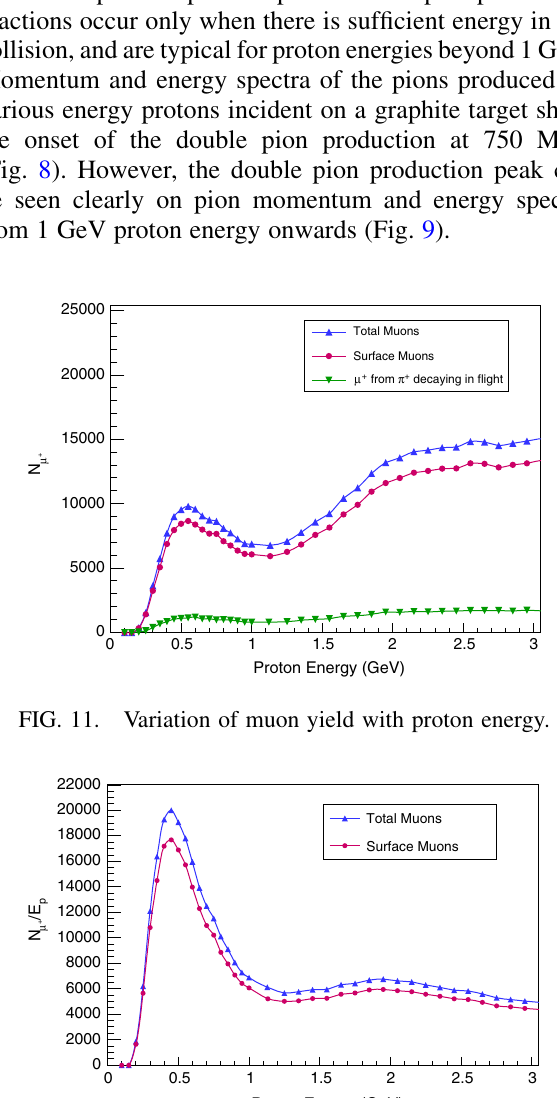
FIG. 12. Normalization to the incident proton energy.